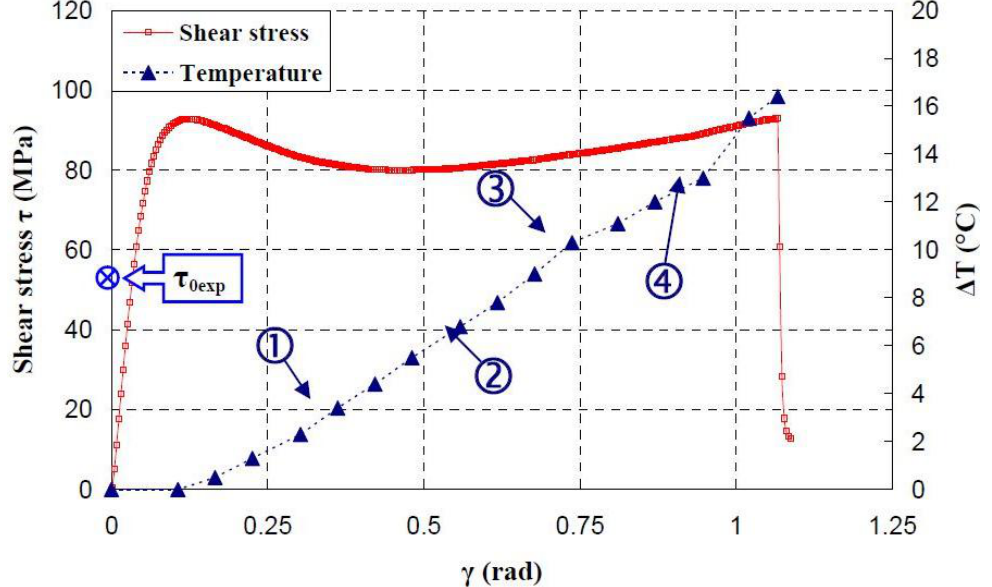
Figure 24. Thermal dissipation and shear stress of PMMA polymers during the torsion